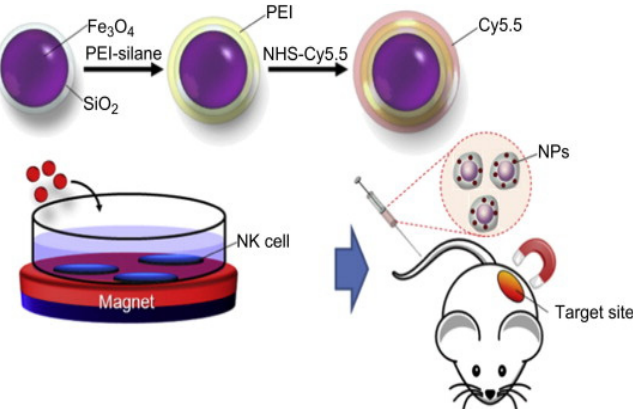
Figure 11. Schematic illustration of MNPs loaded in NK cells delivered to the tumor site and targeted with an external magnetic field. Reproduced with permission from [115] by Elsevier, 2012. Table 2. Role of MNPs in immune cells.